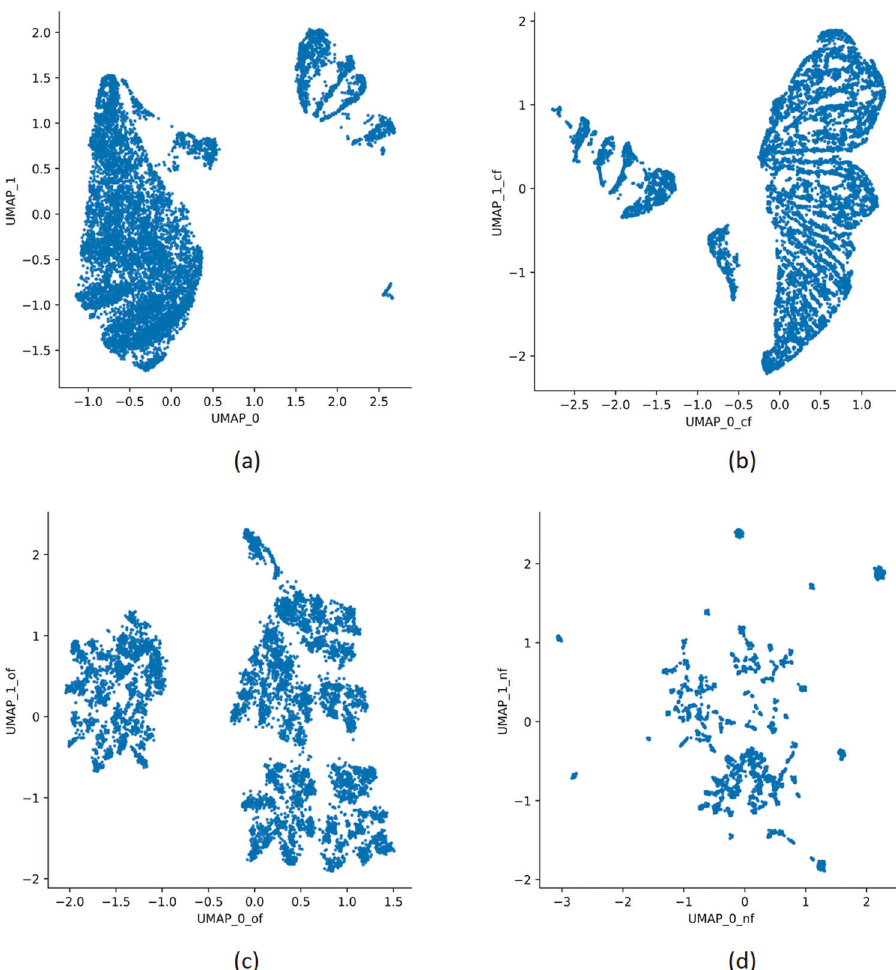
Fig. 2 The low dimensional UMAP visualisations of data for several data types. a UMAP clusters for all the features with the Euclidean metric. b UMAP clusters for continuous features with Euclidean metric. c UMAP clusters for ordinal features with Canberra metric. d UMAP clusters for nominal features with Hamming